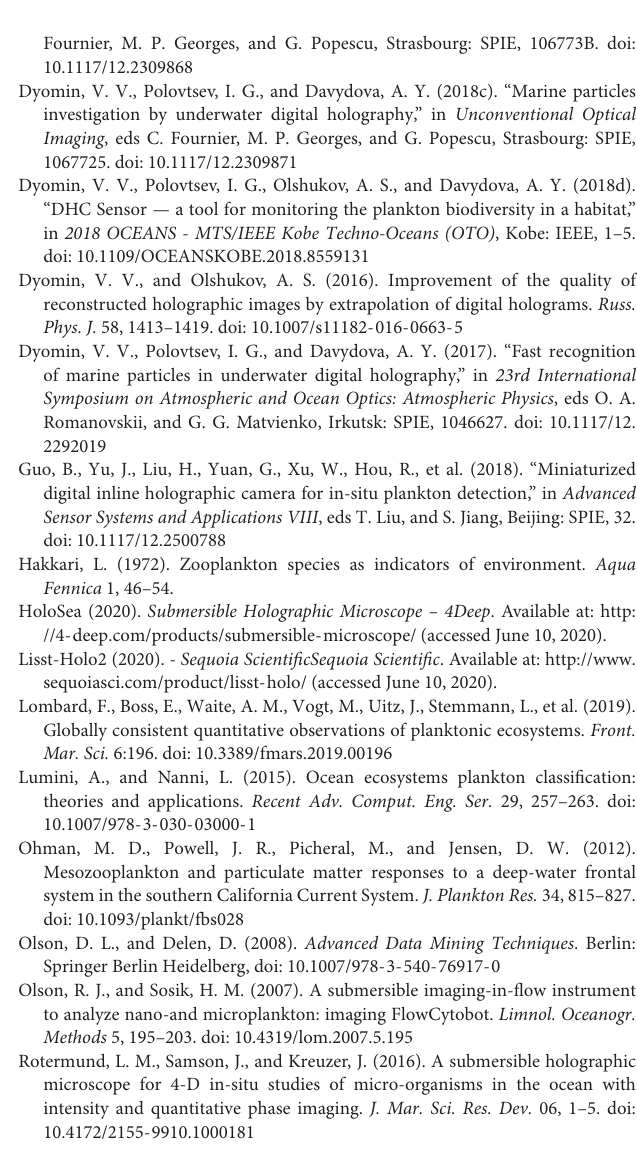
FIGURE S1 | (A) Histogram of particle distribution by taxon (automatic classification). Taxon designation: 1 – phytoplankton colony, 2 – phytoplankton